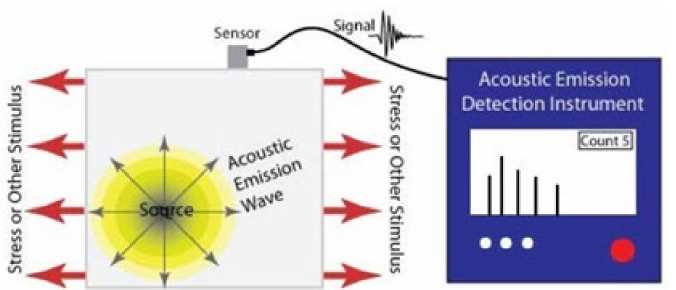
Figure 15. Schematic of AE technique (NDT Resource Center at Iowa State